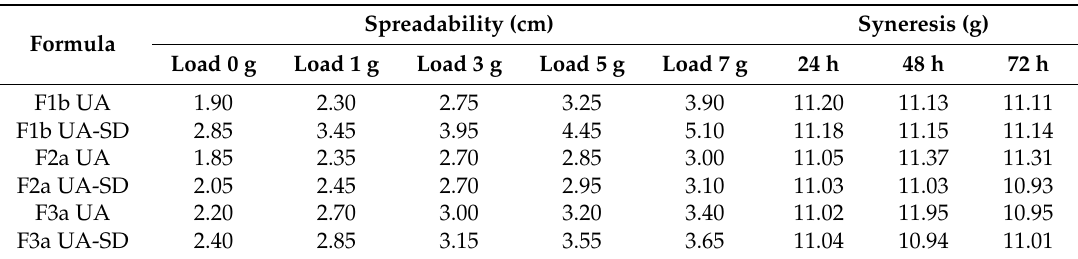
Table 4. Spreadability and syneresis test result.